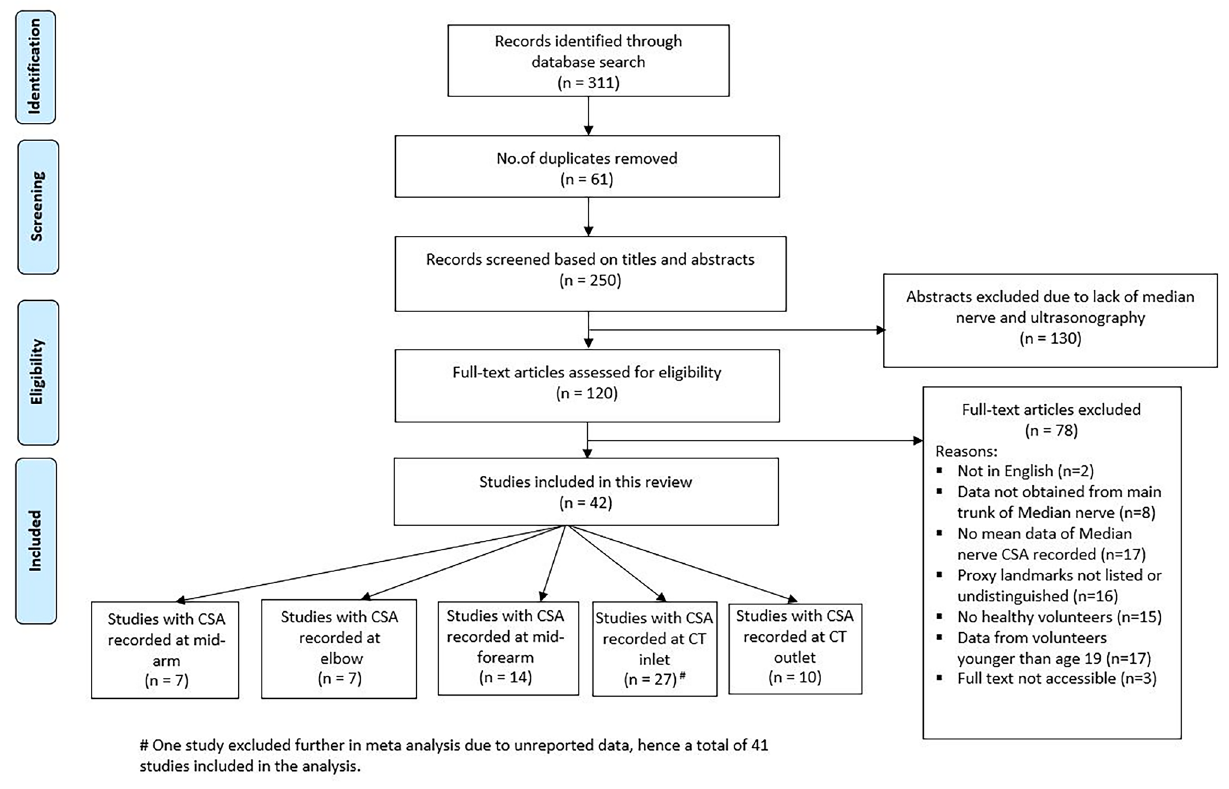
Figure 2. PRISMA Flowchart on steps for inclusion and exclusion of articles for